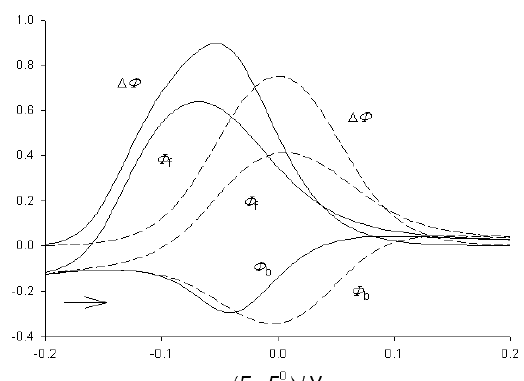
Figure 1. Square-wave voltammograms of electrode reaction (1) unaffected by the reactant adsorption ( K * = 0) (a broken line), and influenced by the fast, equilibrated adsorption of reactant (K * = 33.33 and k * E = -0.3 V vs E 0 , dE = 5 mV and E st response (ΔΦ) and its forward (Φ components are hown.